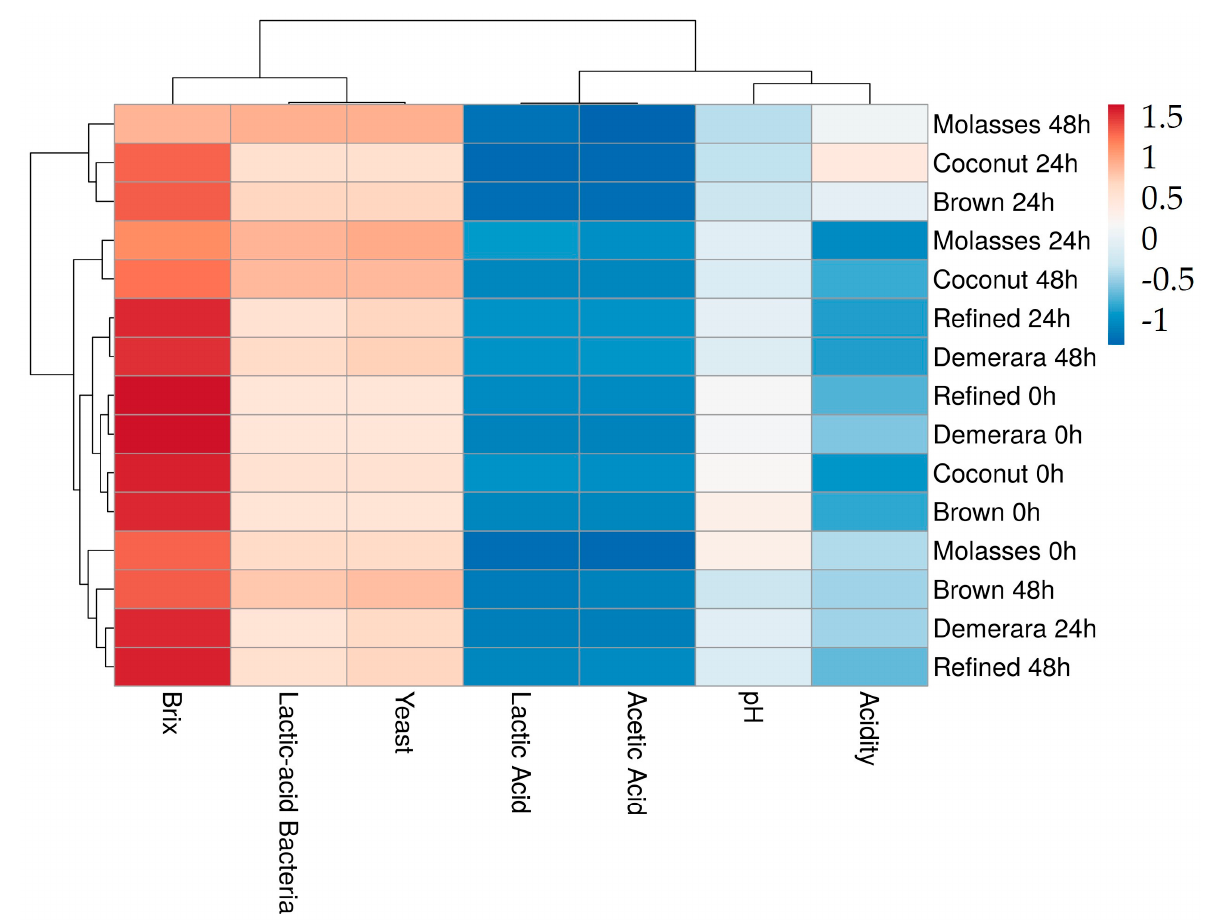
Figure 7. Multivariate analysis in the form of a Heatmap of the physicochemical and microbiological parameters of water kefir beverages fermented from different sugary substrates (Demerara, Molasses, Brown, Refined and Coconut).